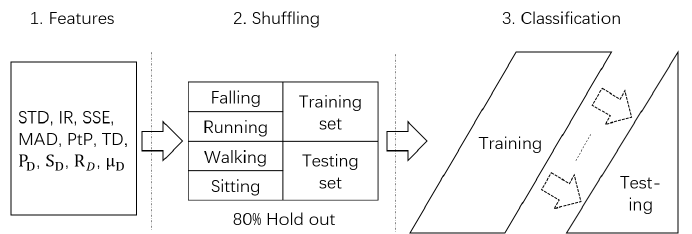
Figure 9. Classification data flow.